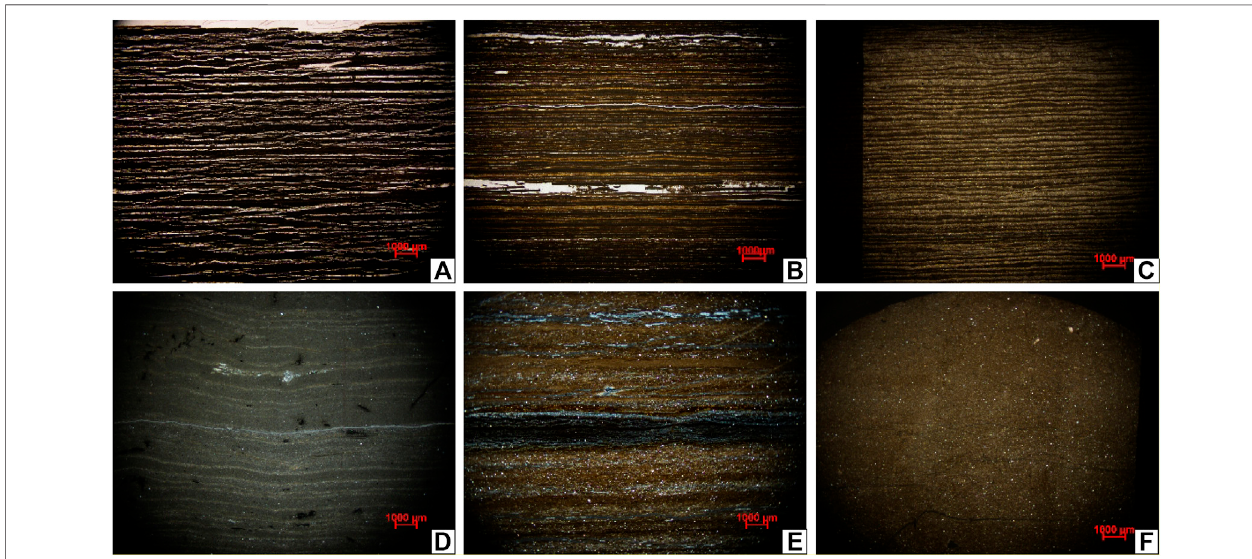
FIGURE 3 | Microscopic characteristics of six favorable petrographic phase types. (A) Organic-rich lime shale (OR-LS), W33, 1,950.95 – 1,950.96 m, 1x ( − ); (B) organic-rich laminoidlime clayrock (OR-L-LC);G3, 2,159 – 2,159.02 m,1x( − ); (C) organic-richlaminoid claymicritic limestone (OR-L-AM), W161, 1,985.7 – 1,985.72 m, 1x (+); (D) organic-bearing banding clay micritic limestone (OM-B-CL), G6, 2,145.76 – 2,145.77 m, 1x (+); (E) organic-rich banding lime clay rock (OR-B-LC), T29, 2,069.8 – 2,069.82 m, 1x (+); (F) organic-bearing lumpy clay micritic limestone (OM-L-CL), W161, 1,908.44 – 1,908.46 m, 1x (+).